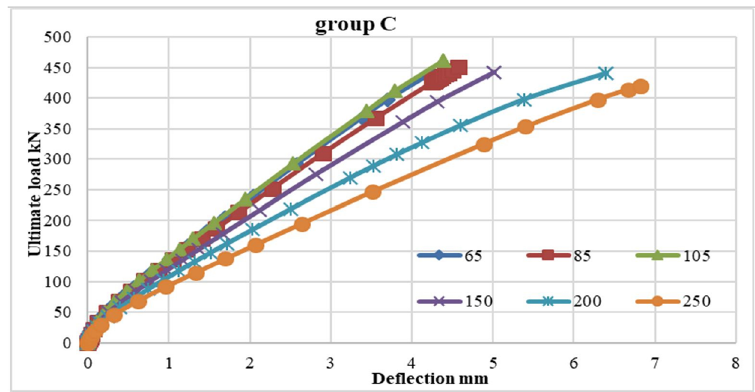
Figure 13: Load – de fl ection for the specimens of Group